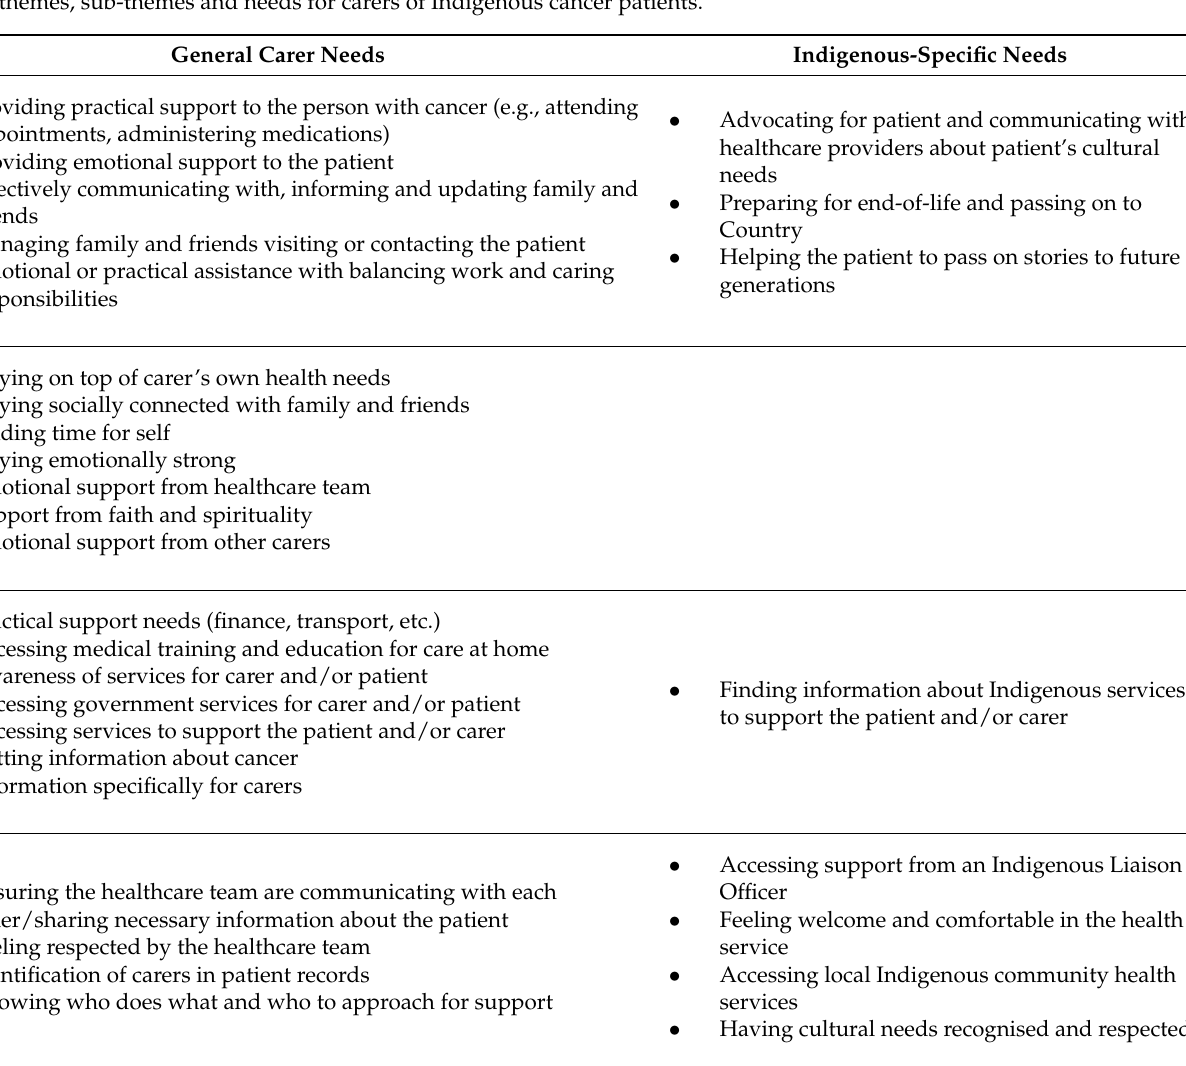
Table 2. Summary of themes, sub-themes and needs for carers of Indigenous cancer